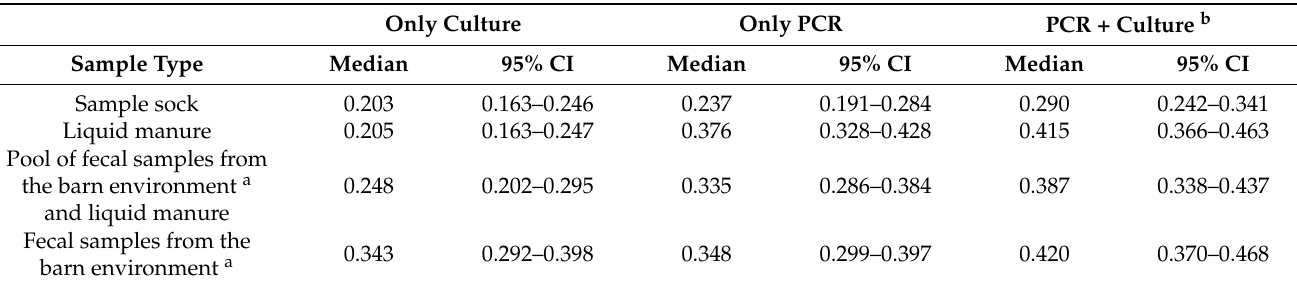
Table 3. Posterior median and 95% CI of the sensitivity of environmental samples from large low- prevalence dairy herds, analyzed by bacterial culture or real-time PCR or both laboratory methods, regarding the detection of MAP at herd level (one sampling